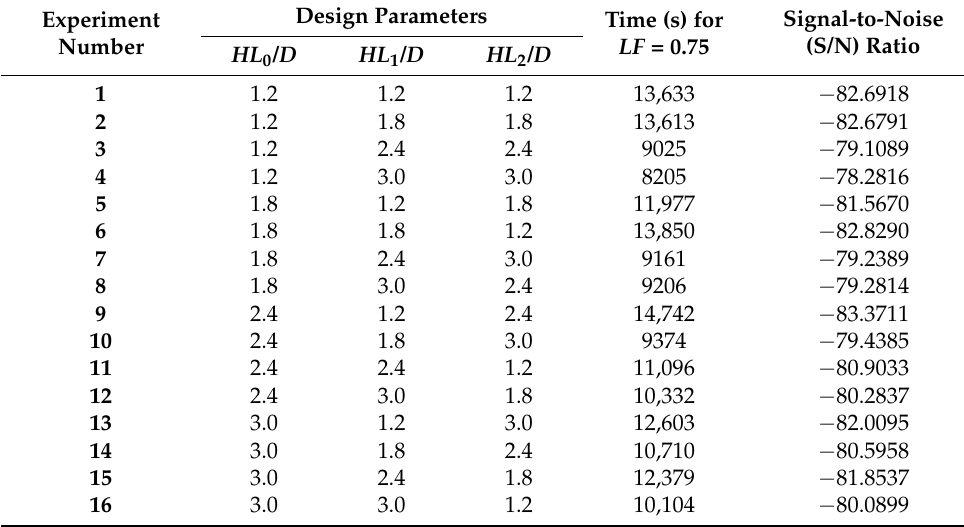
Table 3. Taguchi L16 orthogonal table for three geometrical design parameters and four